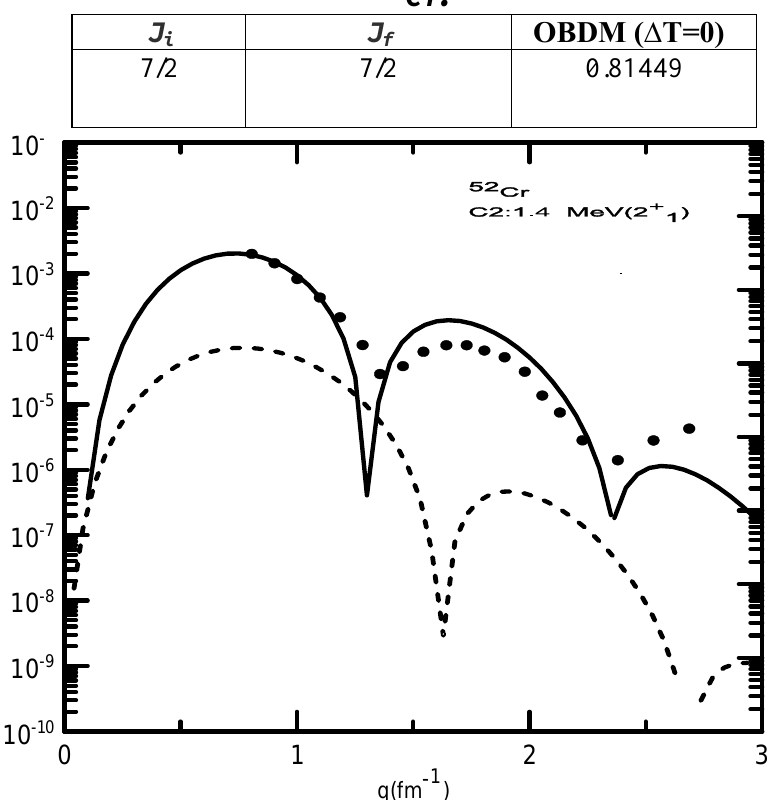
Table 3: The values of the OBDM elements for the longitudinal C2 transition 2 + 2of 52 Cr.